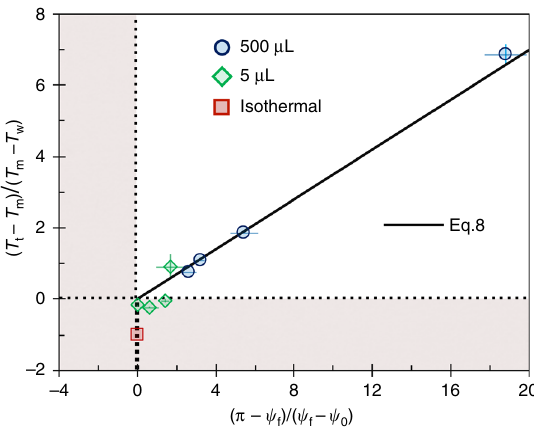
Fig. 5 Partial freezing of bubbles. The critical angle at which the freeze front completely stops was found by balancing the conduction of heat across the icy and liquid portions of the bubble (Eq. 8). The isothermal condition corresponds to the vertical dashed line, where complete freezing occurs ( ψ f = π , square data